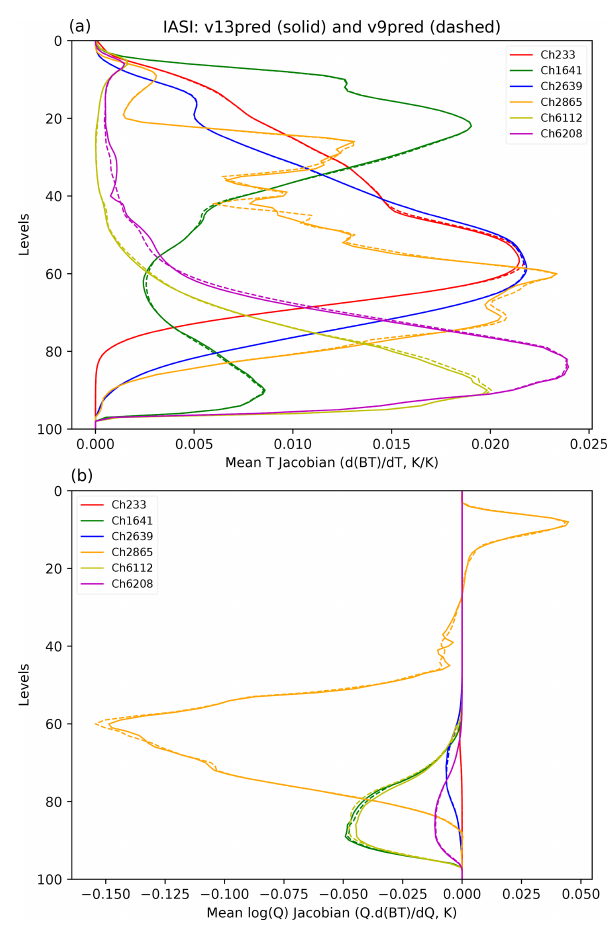
Figure 11. Mean IASI temperature (a) and water vapour (b) Ja- cobians for v13 predictors (solid lines) and v9 predictors (dashed lines) for the 83 training